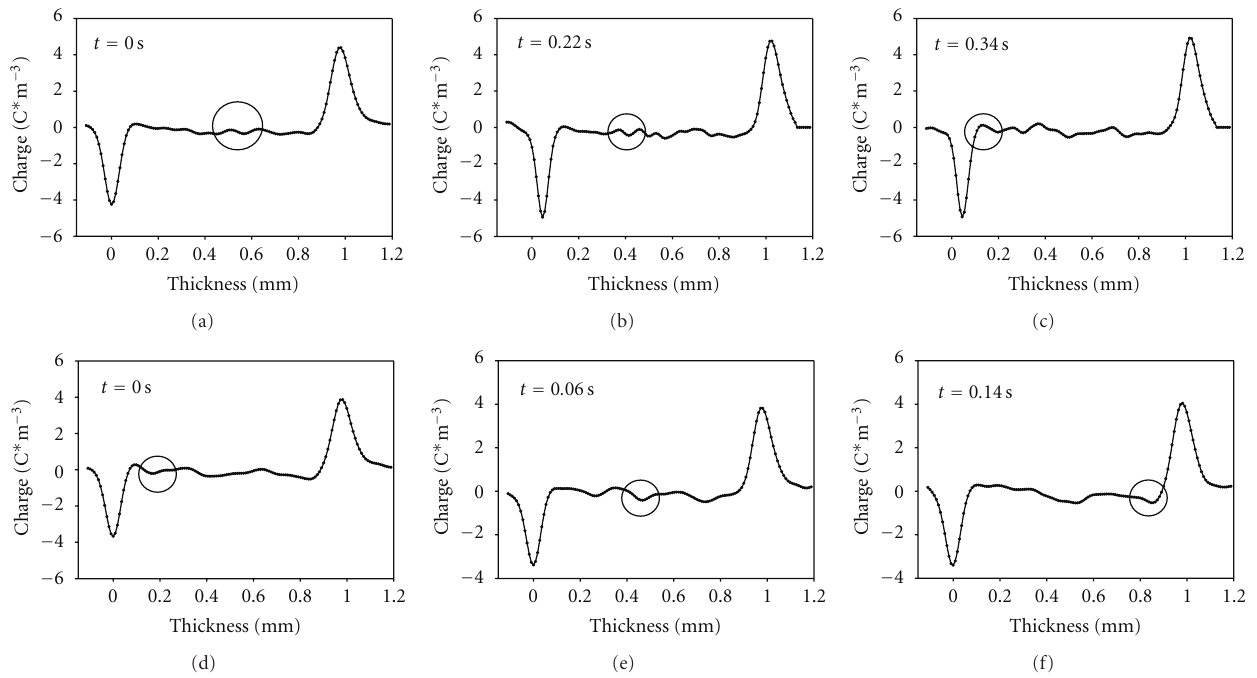
Figure 7: Evolution of charge profiles in specimen no. 20 under an electrical field of 10kV/mm and temperature of 70 ◦ C for a positive charge pulse (a)–(c) and a negative charge pulse